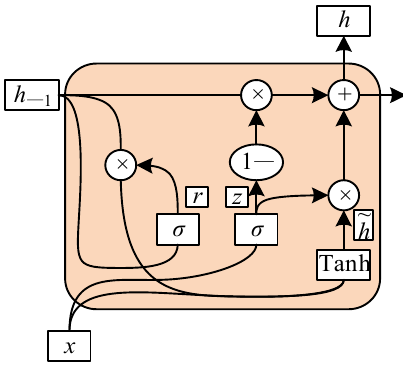
Figure 6. The structure of GRU.